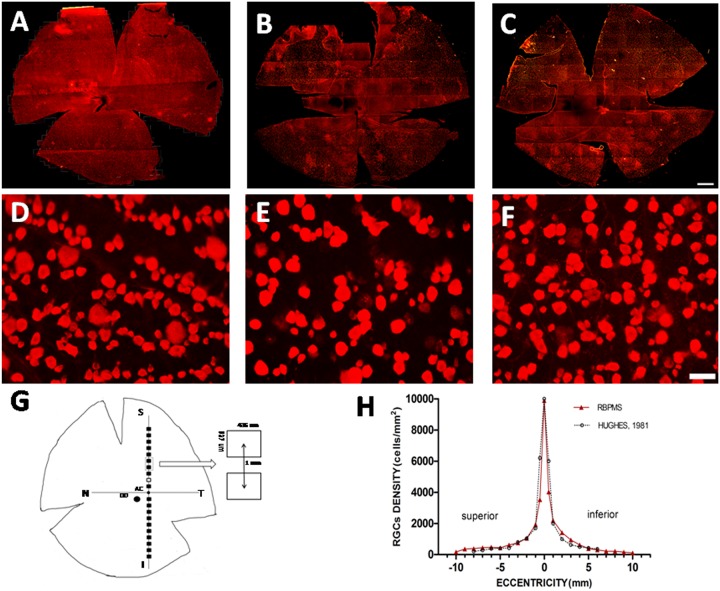
Number and density distribution of RBPMS-RGCs under different conditions.A-C reveal retinal distribution patterns of RBPMS expressing RGCs under different experimental conditions. A: RBPMS expressing RGCs in a normal retina, B: ONC retina, C: ONC+ALA retina. Scale bar: 2 mm. D-F show magnified micrographs of RBPMS immunoreactive RGCs (Sampling location: 2 mm superior to the AC from A-C) under different experimental conditions: D: normal retina, E: ONC, F: ONC + ALA. Scale bar: 50 um. G shows a diagram of sampling sites along the vertical meridian on each retina. The open rectangle depicts retinal location where micrographs were taken. The filled rectangles show sampling locations at different eccentricities. The large filled circle represents the optic disk (OD) and the small filled circle at the intersection of horizontal and vertical meridians shows the AC. Panel H shows a comparison of RBPMS stained and HRP stained density profiles. The filled red triangles and solid line depict RBPMS. Open black circles and the dashed profile which is taken from Hughes (1981, his Fig 13), is shown for comparison. The open arrow indicates sample area dimension and the distance between centers of two sample sites. Each sampling area was measured as 436×327μm2. The distance between centers of neighboring sampling areas is 1 mm.